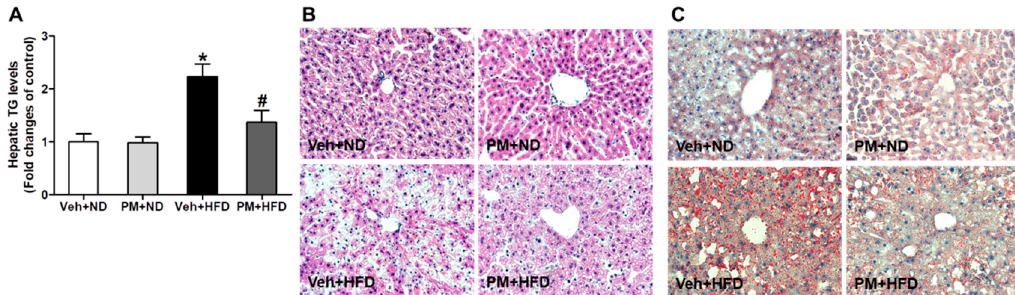
Figure 5. The effect of PM extract on hepatic triglyceride (TG) and lipid accumulation in HFD-fed mice. Hepatic TG levels ( A ) and representative images (magnification 200X) of H&E ( B ) and Oil-red O staining ( C ). The mice fed with ND or HFD were treated with PM extract or vehicle for 16 weeks, and the liver tissues were collected. Data are the mean ± SEM. * p < 0.05 vs. Veh + ND group; # p < 0.05 vs. Veh + HFD group.